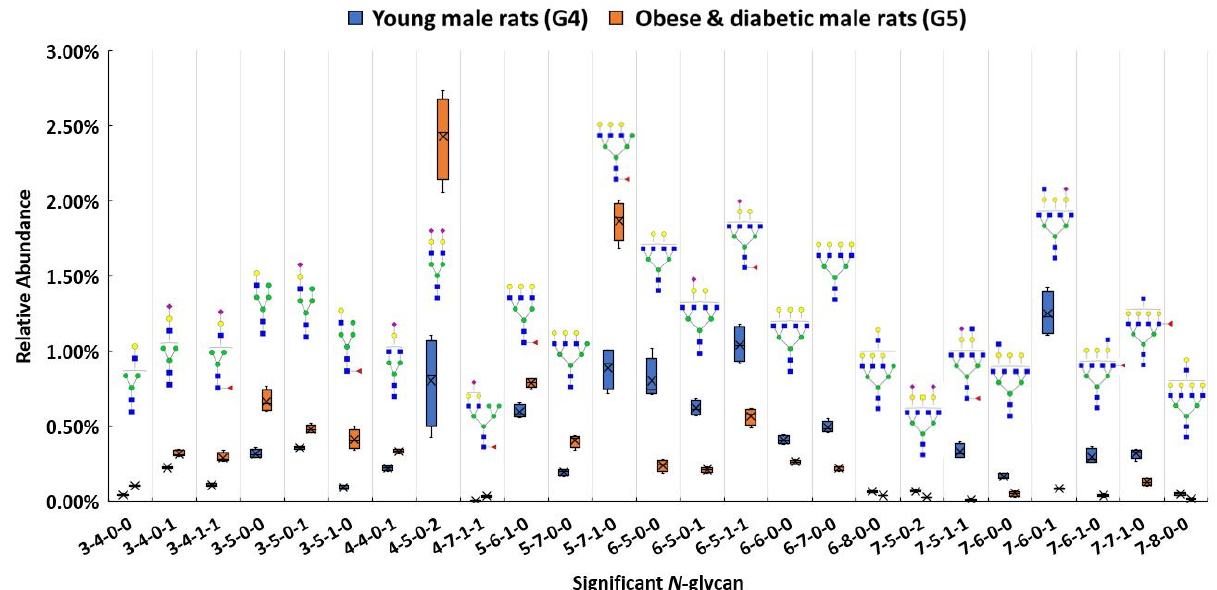
Figure 4. Box plot for relative abundance of 25 significant N -glycans ( p < 0.0004) between young male control (G4) and obese and diabetic male (G5). The putative structure was assigned to each glycan composition. The X axis denotes the four-digit codes for N -glycan compositions. The Y axis is the relative abundance. Symbols: see Figure 2.